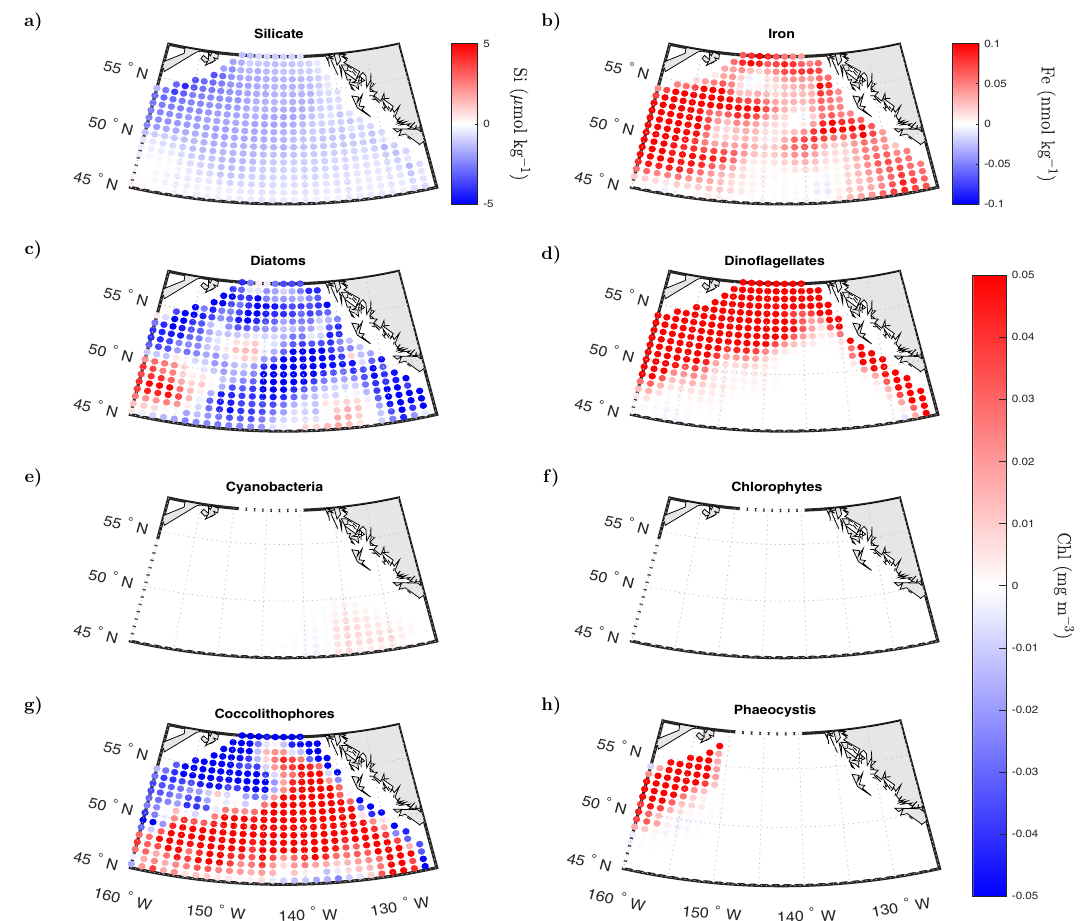
Fig. 5 Spatial pattern in GOA nutrient and PFTs anomalies between May and December of 2014. a , b Mean anomaly in modeled surface ( a ) silicate ( μ mol kg − 1 ) and ( b ) iron (nmol kg − 1 ). c – h Mean anomaly in the modeled surface chlorophyll biomass (mg m − 3 ) of ( c ) diatoms, ( d ) dino fl agellates, ( e )